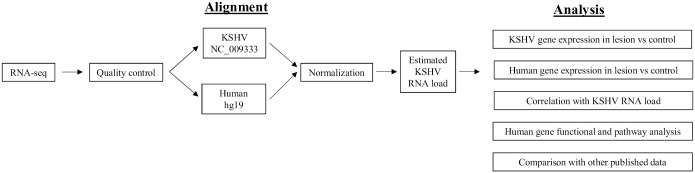
Schematic of RNA-seq analysis work flow.